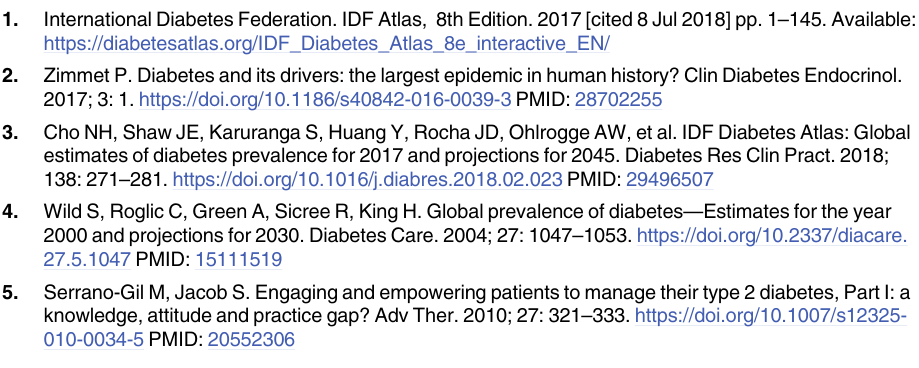
S1 Table. Themes, sub-themes, codes, quotations within the conceptual model (via grounded theory Approach). S2 Table. Consolidated criteria for reporting qualitative studies (COREQ): 32-item check-